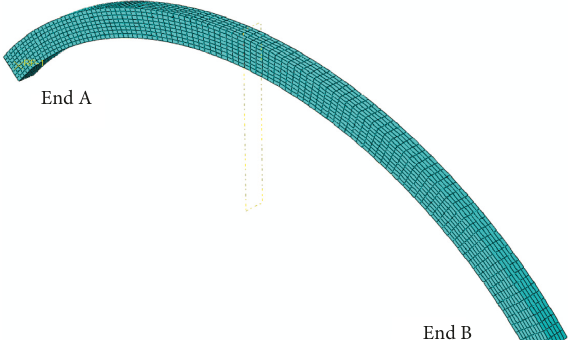
Figure 9: FE model developed by ABAQUS program for circular arch.